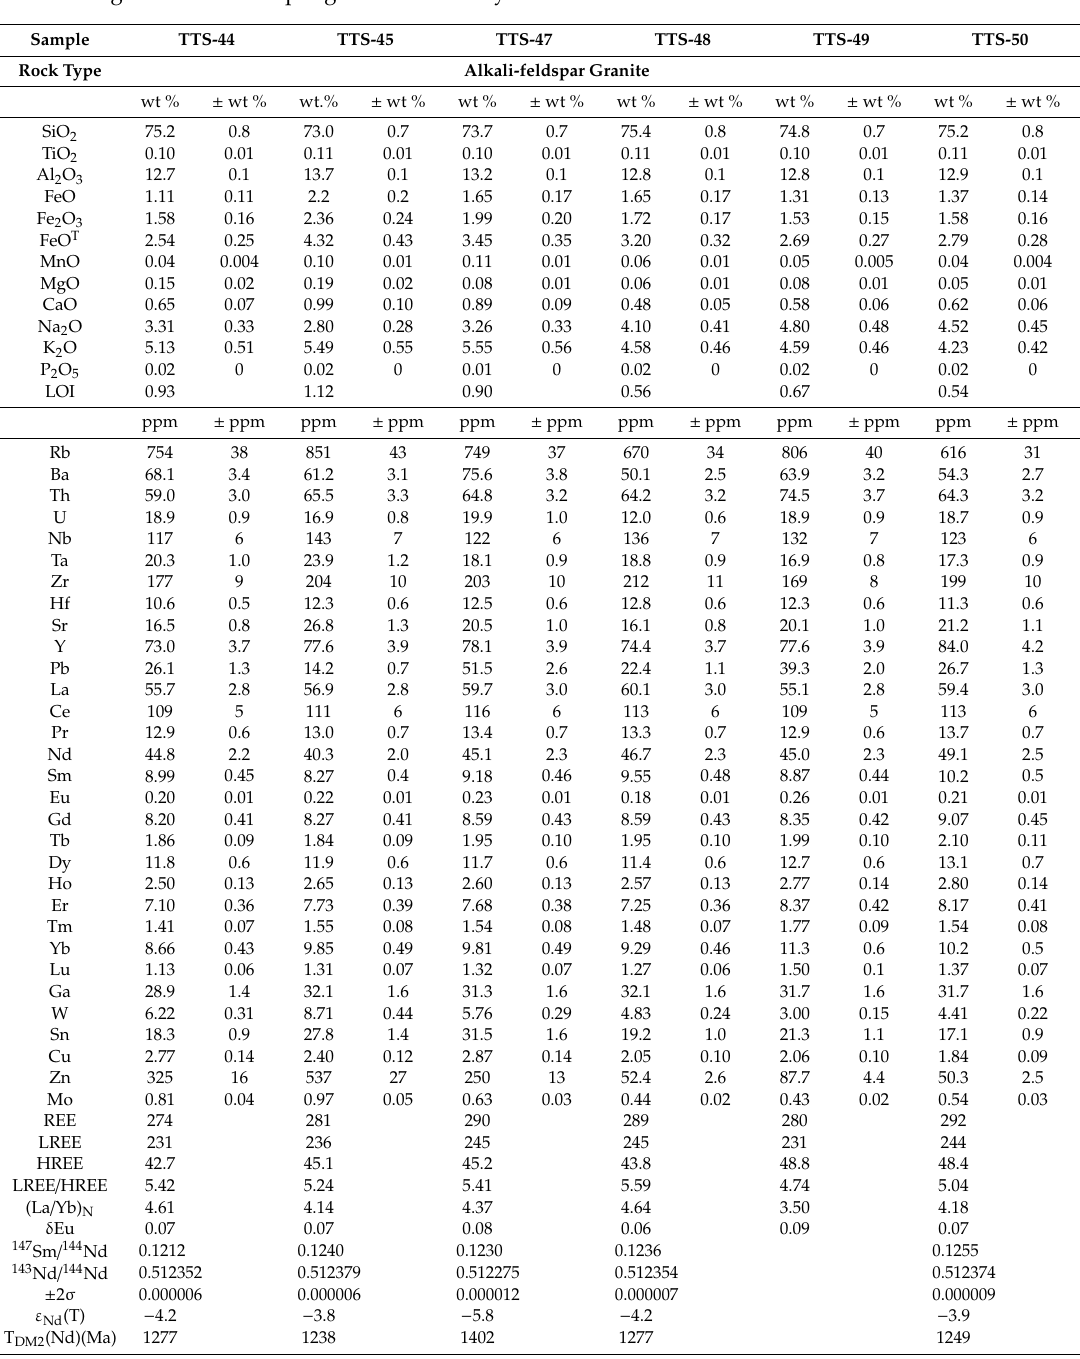
Table 2. Major (wt%), trace element (ppm), Nd isotope compositions and T DM2 (Nd) ages of the Tiantangshan alkali-feldspar granite and trachydacite.